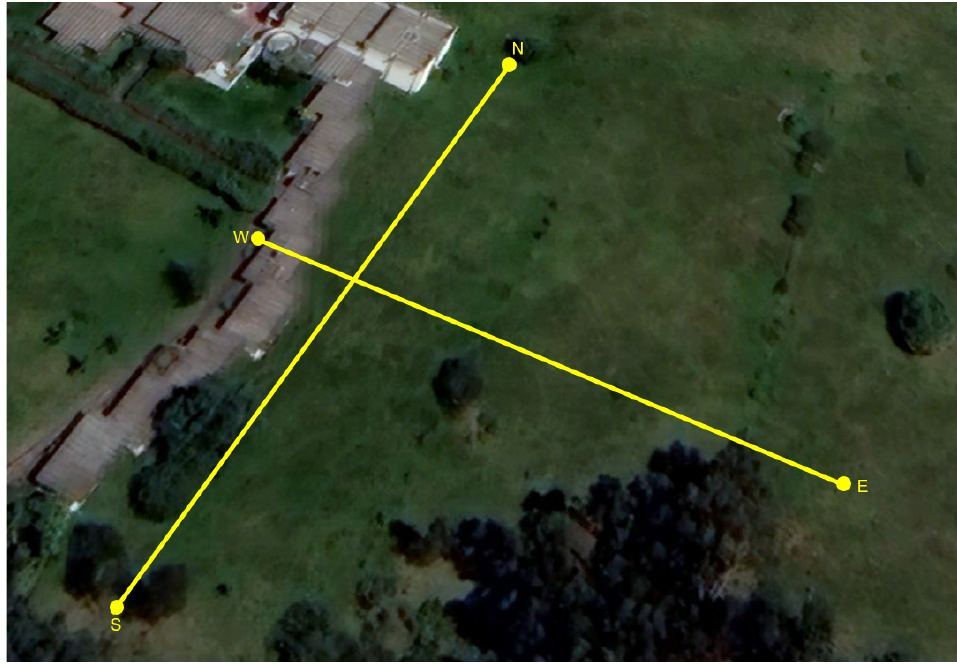
Figure 2. Schematic representation of the location of the orthogonal dipoles, corresponding to the USME station.